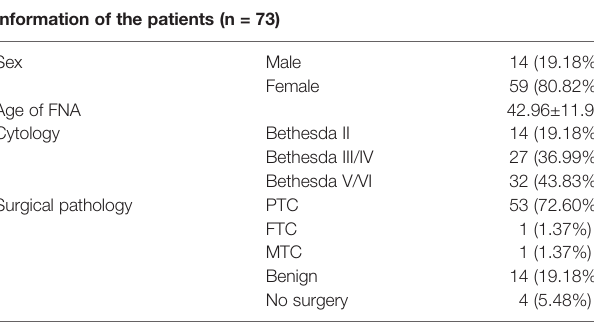
Sex, age, preoperative cytology, and surgical pathology are